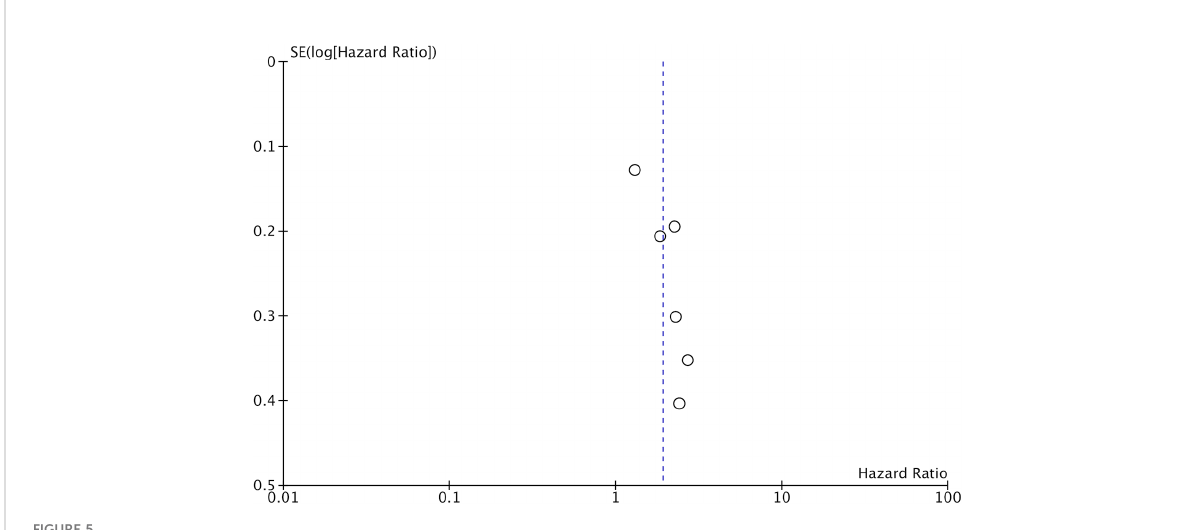
FIGURE 5 Funnel plot for the meta-analysis on the prognostic ability of GNRI for DFS in CRC